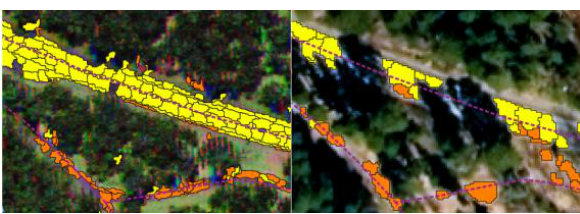
Figure 1. An aerial ortho image (left), Titan intensity image (middle), and land cover classification result (right) from a 300 m × 300 m subarea. Ortho image © National Land Survey of Finland (NLS) 2013. The land cover classification is based on the multispectral ALS data.